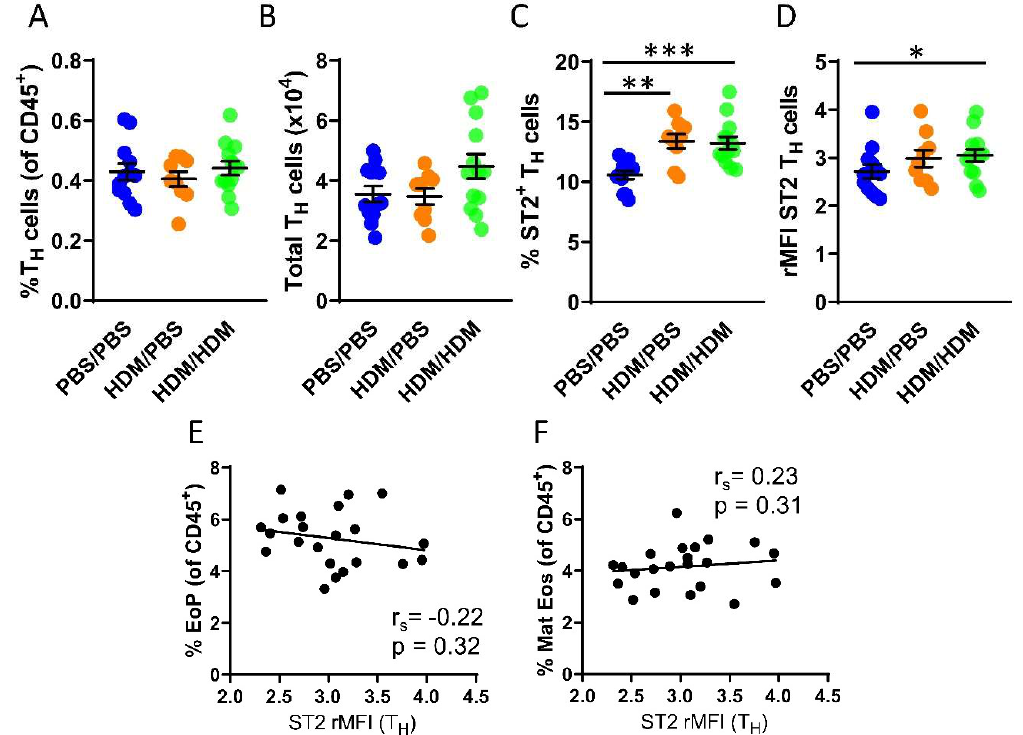
Figure 3. IL-33-responsive T H cells during eosinophilia in the bone marrow. ( A ) Number of T H cells among all CD45 + bone marrow leukocytes. ( B ) Total number of T H cells per femur. ( C ) Number of ST2 + T H cells. ( D ) ST2 expression on T H cells shown as rMFI. Correlation plots of rMFI ST2 on T H